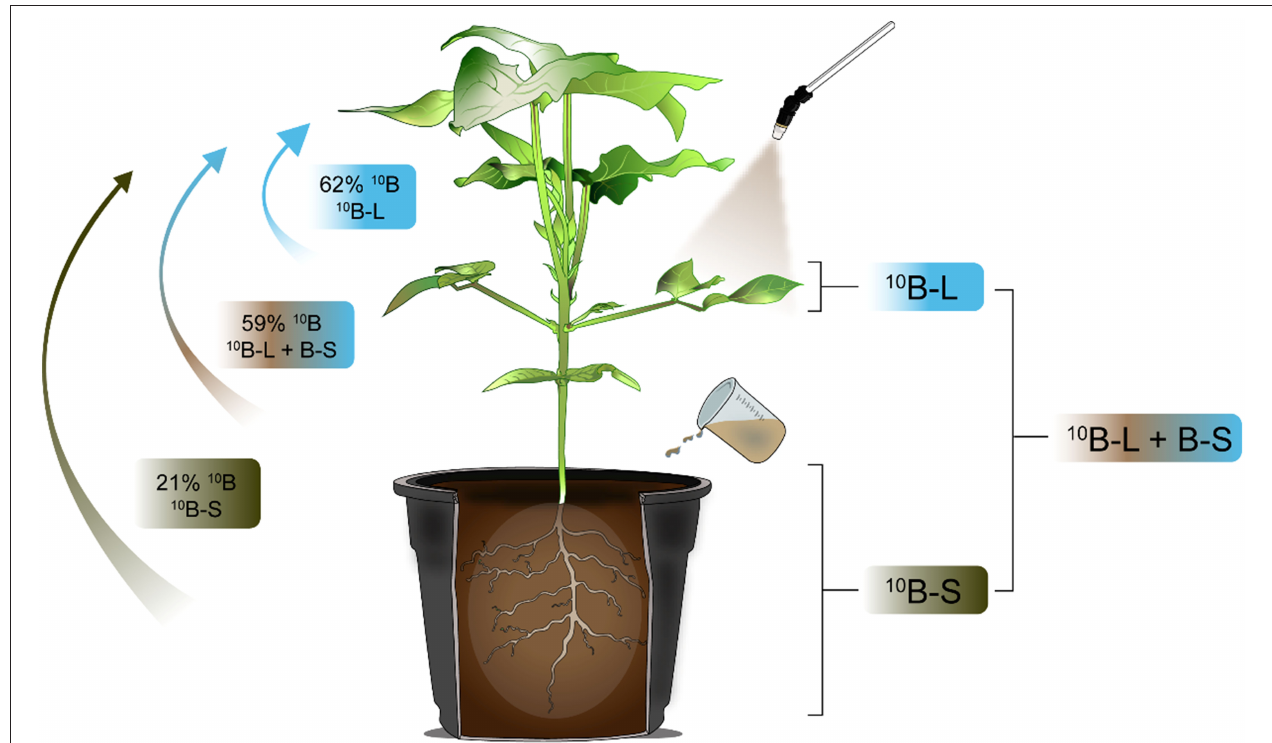
FIGURE 5 | Graphical abstract of the redistribution of 10 B applied in different ways in cowpea